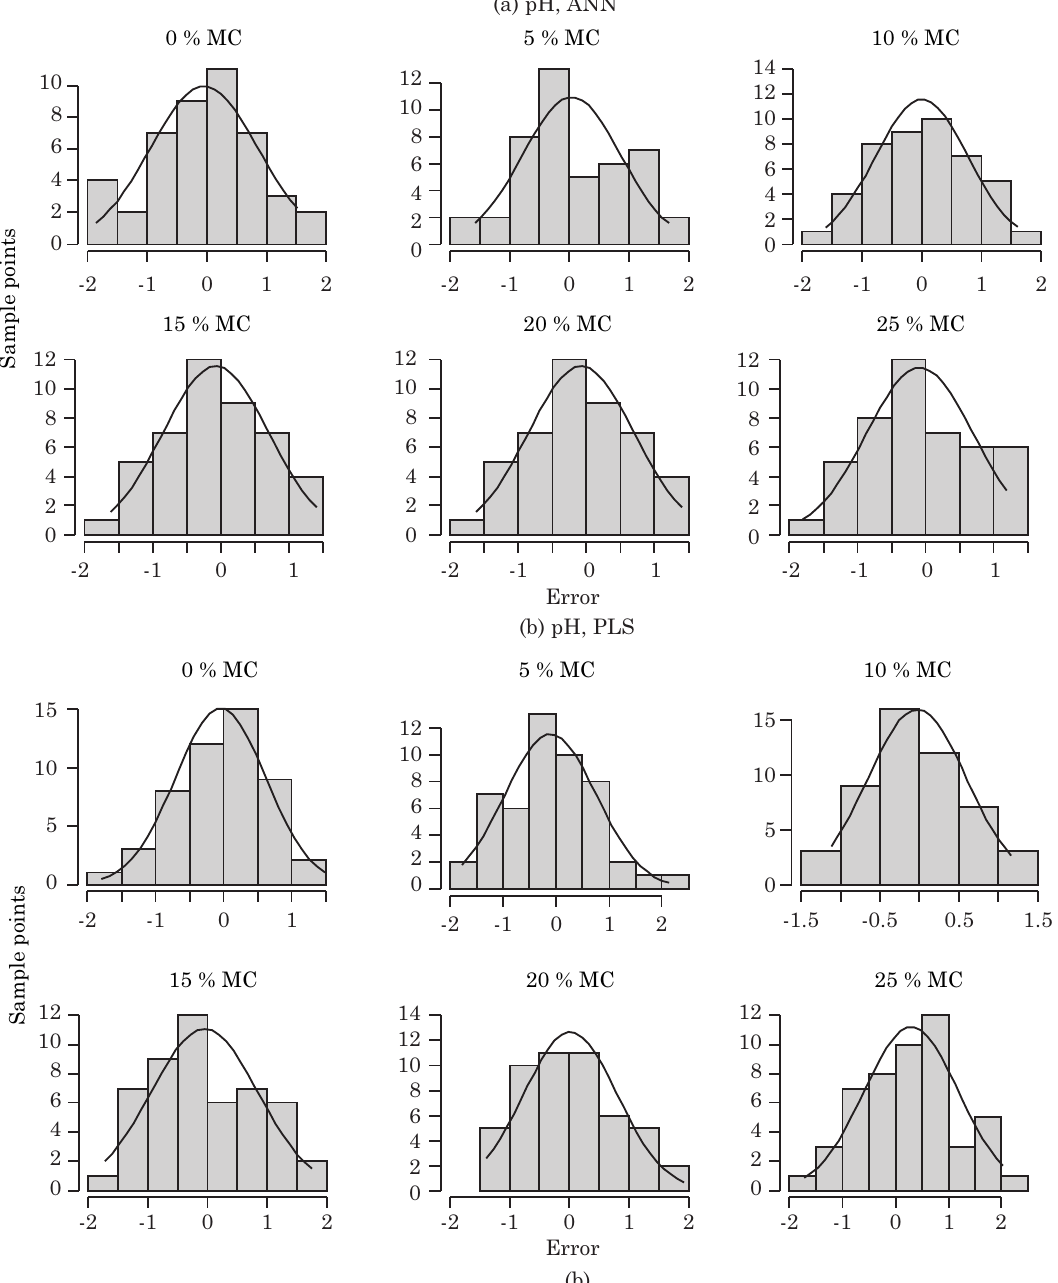
Figure 3. Histogram of normal distribution of error for the artificial neural network (ANN) predictions (a) and partial least squares (PLS) predictions (b) of